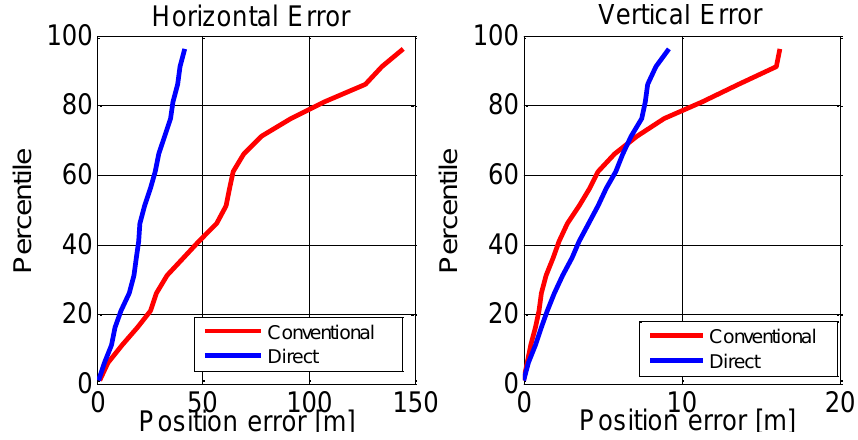
Figure 13. Cumulative histograms of horizontal and vertical position